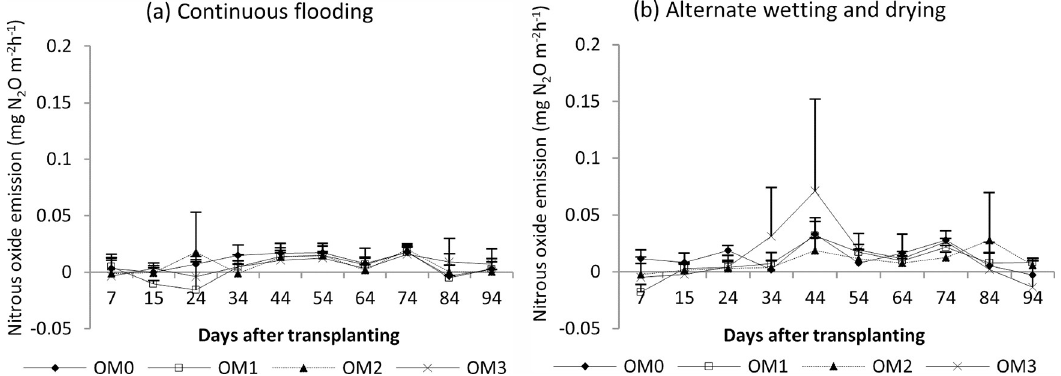
Fig 9. Nitrous oxide emission of rice under (a) continuous flooding and (b) alternate wetting and drying during the wet season, 2017. Mean value ± standard deviation (n = 3).